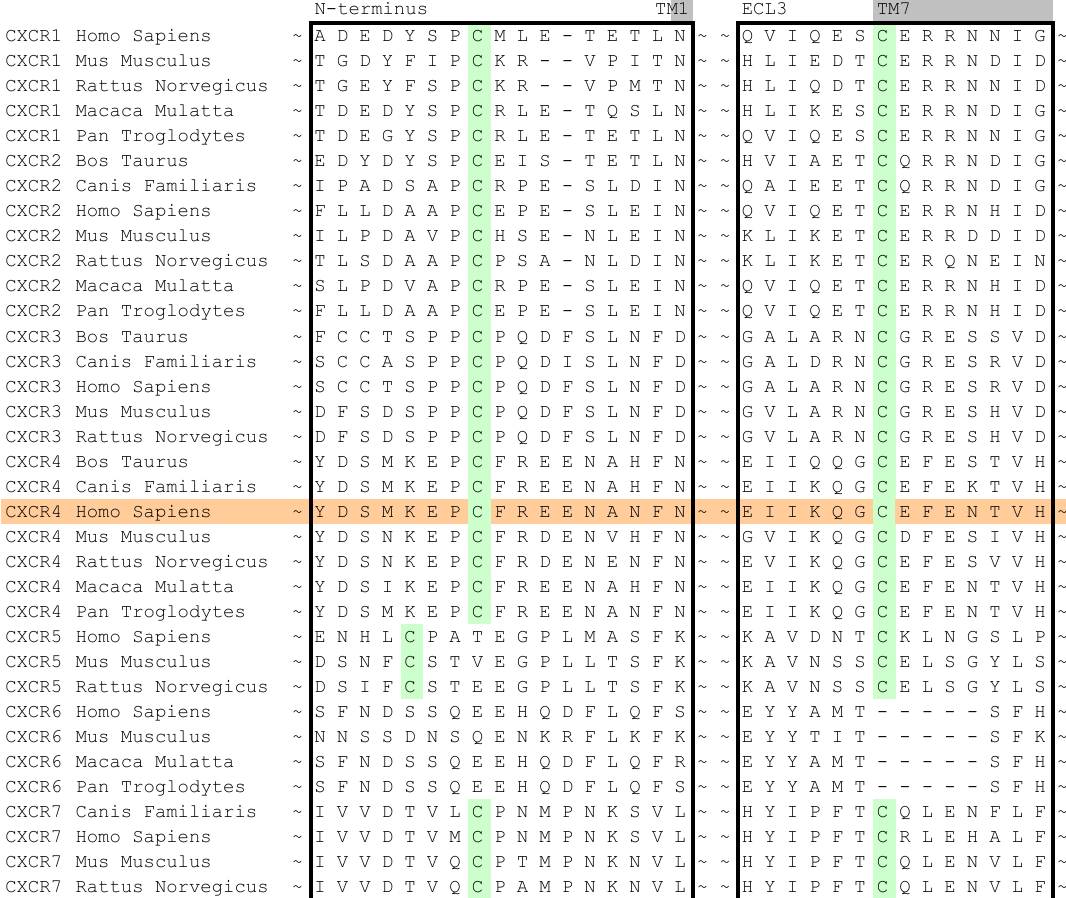
Figure 3. Sequence alignment of the CXCR family including various species. Indicated are the conserved cysteine residues in the N-terminus and the extracellular loop 3 which are hypothesized to form a cysteine